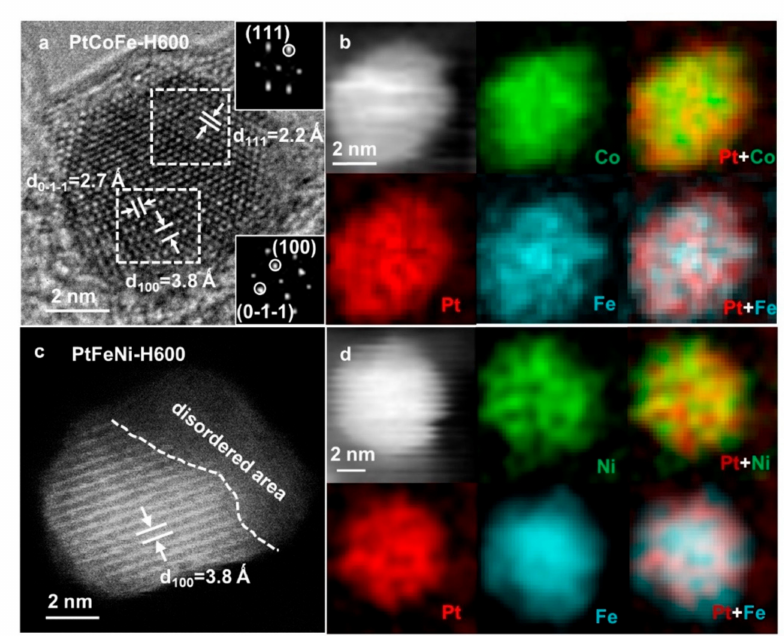
Figure 3. The high-resolution TEM, scanning transmission electron microscopy (STEM), and electron energy loss spectroscopy (EELS) characterizations of PtCoFe-H600 and PtFeNi-H600. ( a , b ) HRTEM image and EELS mapping of PtCoFe-H600; ( c , d ) STEM image and EELS mapping of